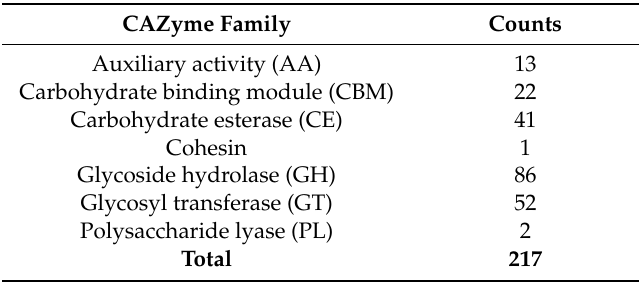
*Average nucleotide identity percentage values between Granulicella strain WH15 and other available Granulicella strains’ whole genomes. Table 3. Carbohydrate-Active Enzyme (CAZyme) categories observed in the WH15